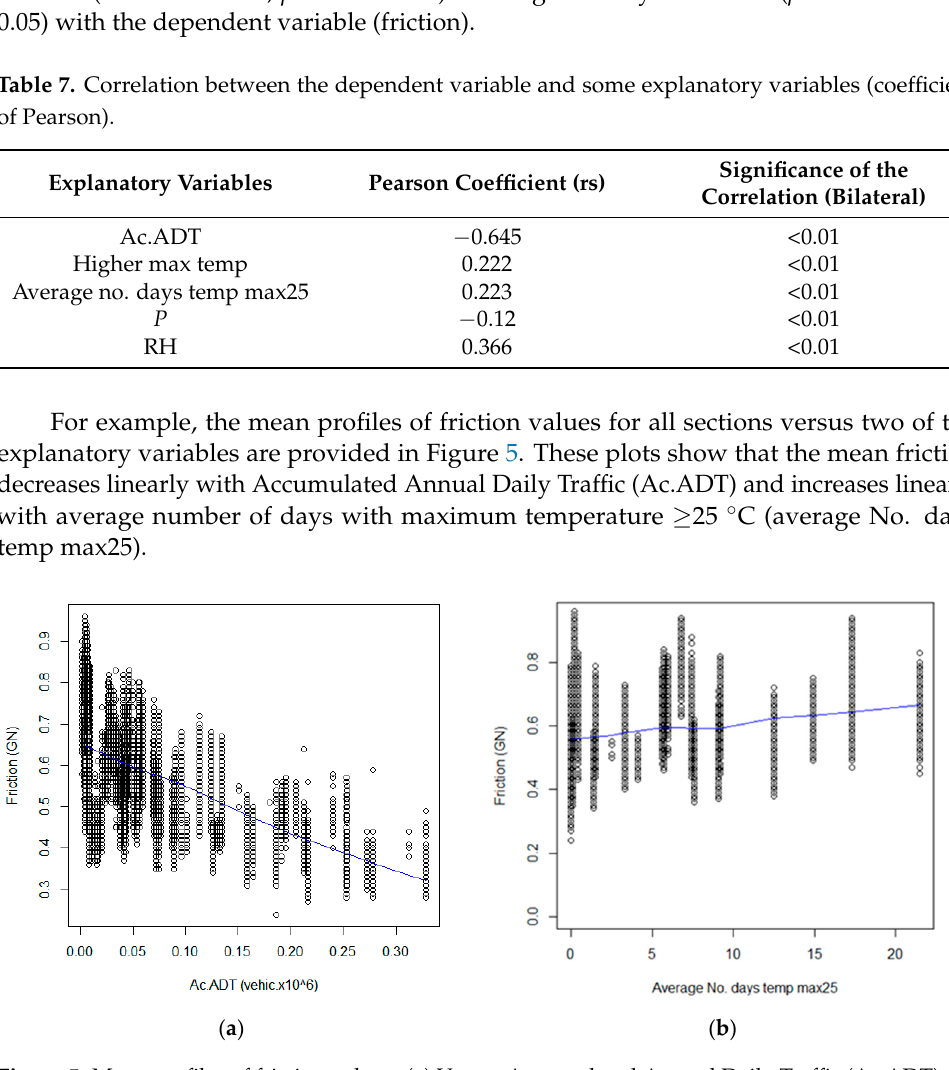
Figure 5. Mean profiles of friction values: ( a ) Versus Accumulated Annual Daily Traffic (Ac.ADT); ( b ) versus average No. days temp max25. Circles are observations and solid blue line is the regression line estimated by local linear regression calculation (loess)